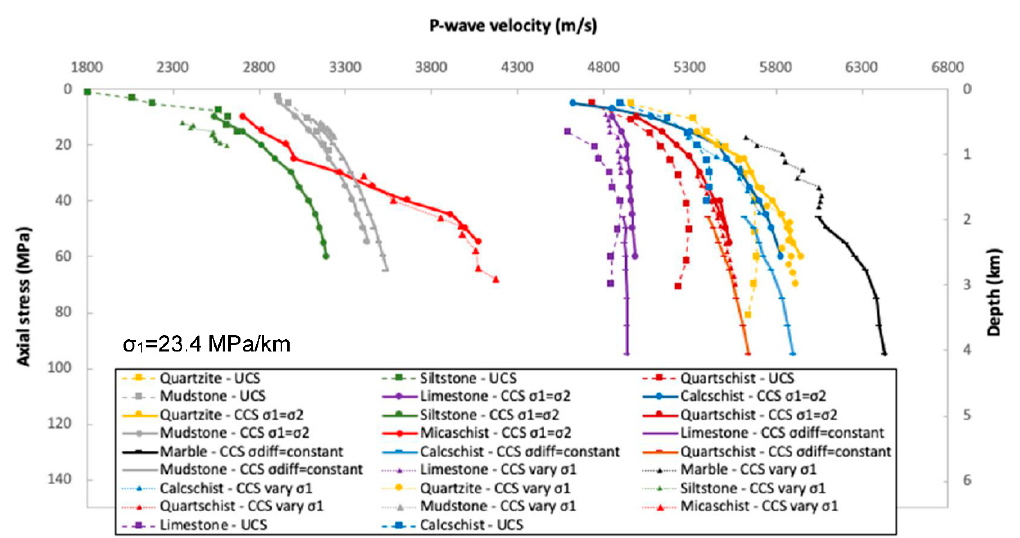
Figure 9. P-wave velocity as a function of axial stress, and thus depth below the surface, for all experiments within series A (UCS), B ( σ 1 = σ 2 ), C ( σ diff = constant), and D (vary σ 1 ), where the exact same core sample was used. Axial stress–depth relationship is taken from [35].